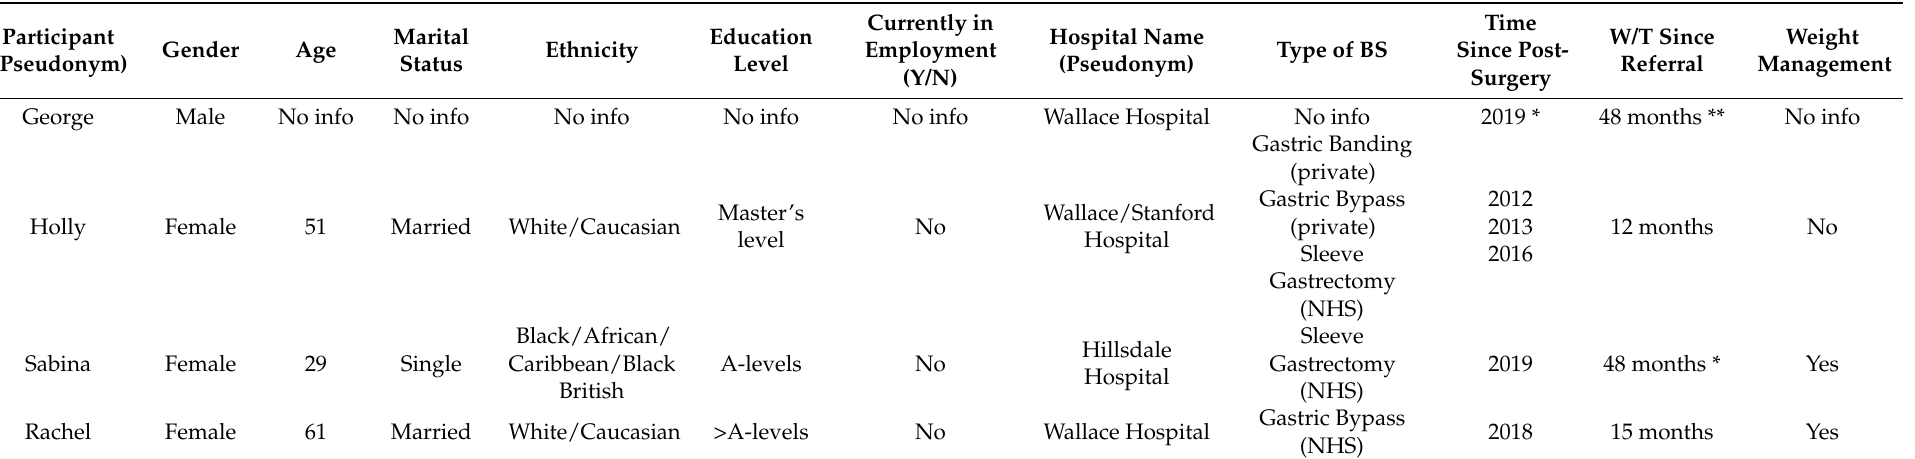
Table 1. Demographic